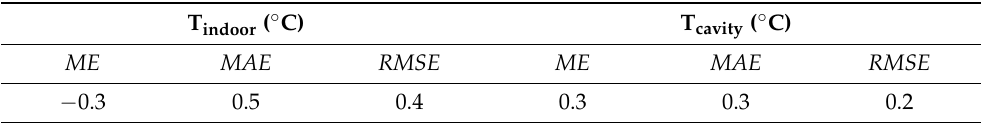
Table 2. Values of ME , MAE , and RMSE obtained by comparing the simulated values and the experimental data acquired during the whole test